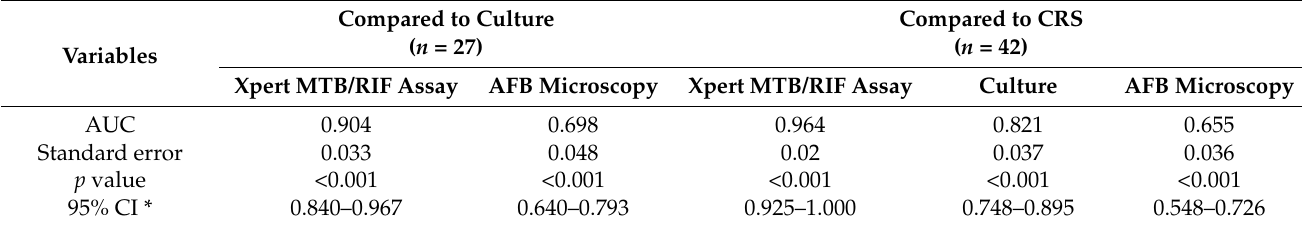
Table 4. AUC of the different diagnostic methods when compared to culture and CRS.